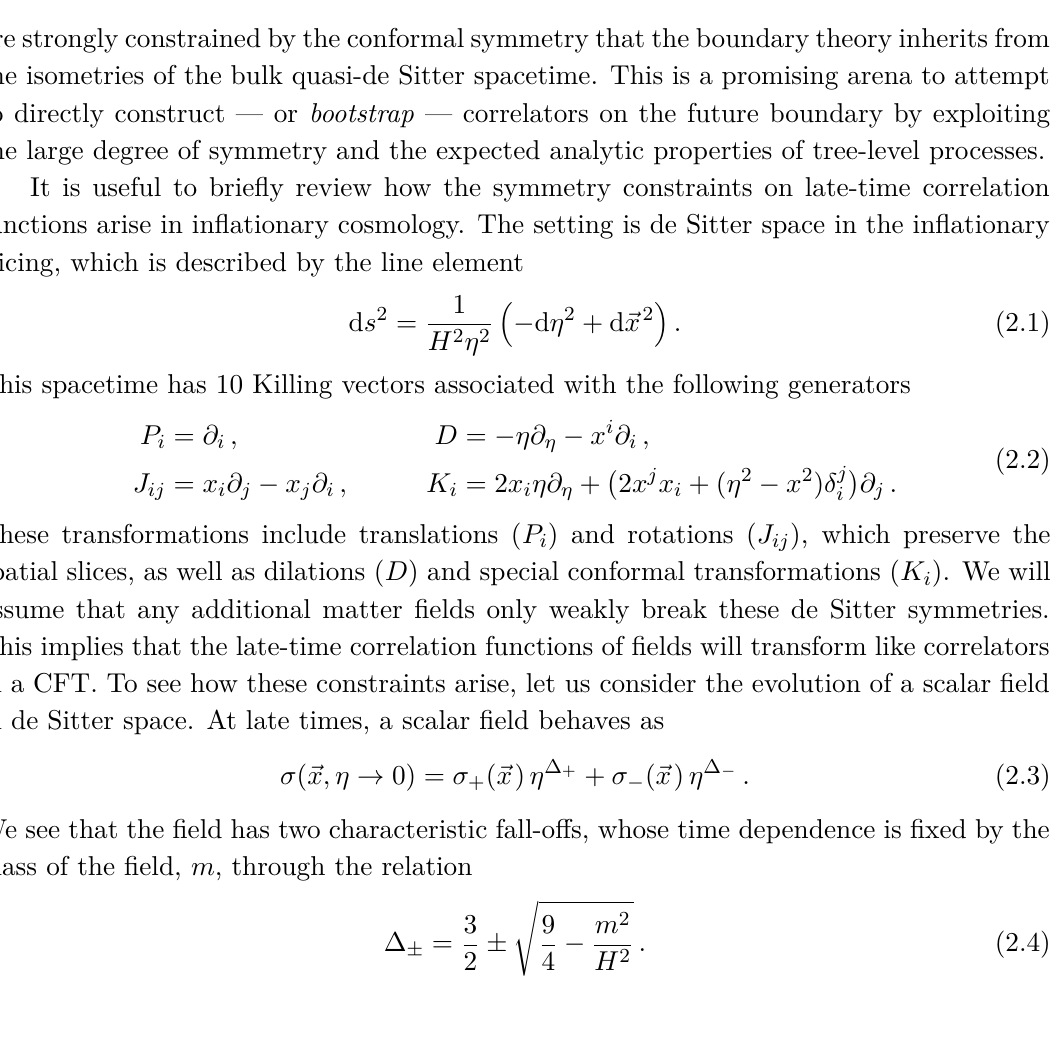
Figure 2. Illustration of particle creation and decay producing correlations on the future boundary of the de Sitter spacetime. The momentum dependence of the boundary correlators encodes the time dependence of the processes in the